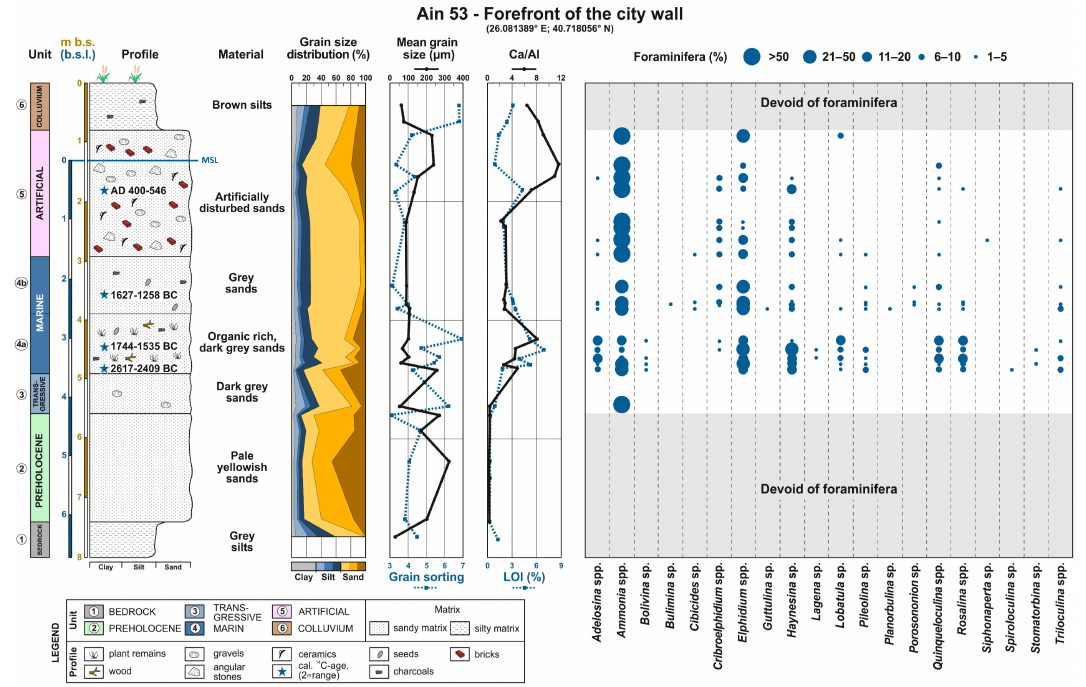
Figure 5. Sediment core Ain 53 (for location see Figures 3 and 4) with geochemical, sedimentological and foraminiferal parameters, supplemented by the interpretation of the depositional units and the dating